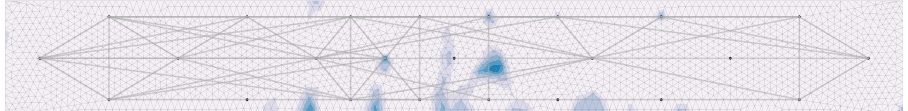
Figure 9. Comparison of the damage localization with an inverse problem for 95 pairs ( a ) and DC-based selected 61 pairs ( b ) using the STIR method with m max = 2.0.